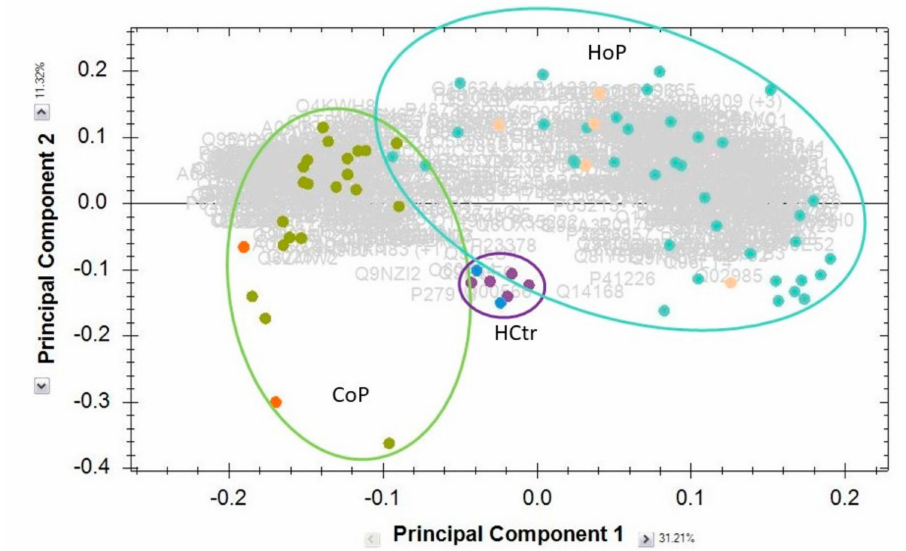
Figure 1. Principal components analysis of shortlisted results from HDMS-based expression analysis (protein assignment by at least two peptides, fold value > 2, ANOVA p ≤ 0.05). The majority of the samples came from males. Light (HoP) and dark orange (CoP) and blue (HCtr) dots indicate the samples from the few participating females. Sample groups were separated as indicated by ellipses.